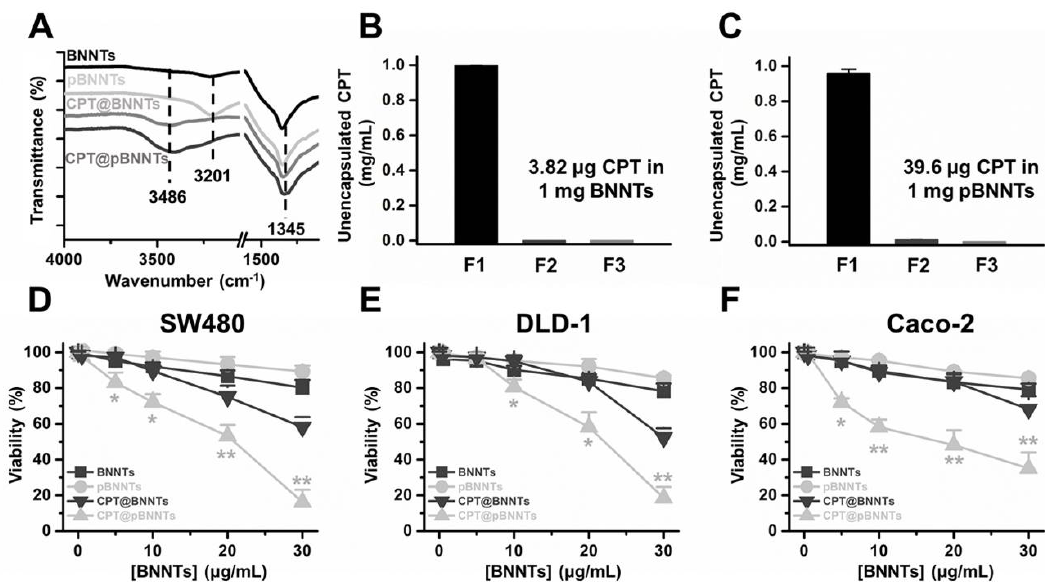
Figure 6. ( A ) Raman spectra of BNNTs and pBNNTs after CPT encapsulation. Estimation of the amount of CPT encapsulated in ( B ) BNNTs and ( C ) pBNNTs. Cytotoxicity induced by control BNNTs, pBNNTs, and CPT, encapsulated by BNNTs and pBNNTs in ( D ) SW480, ( E ) DLD-1, and ( F ) Caco-2 colorectal cancer cells. Error bars represent the standard deviation of tee replicates. * for p < 0.05, ** for p < 0.01.